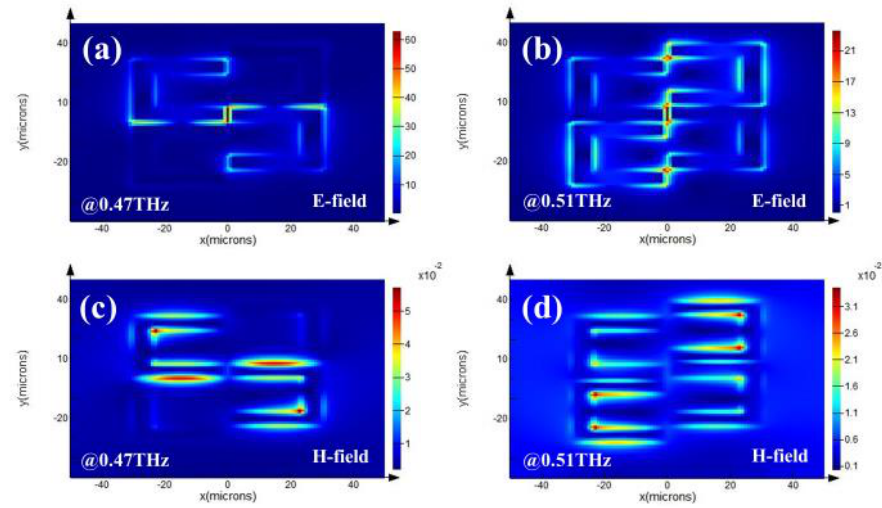
Figure 5. ( a , b ) E-field and ( c , d ) H-field distributions of the RTM device with ( y 2 , y 4 ) = (24, −8) μm in TE mode.